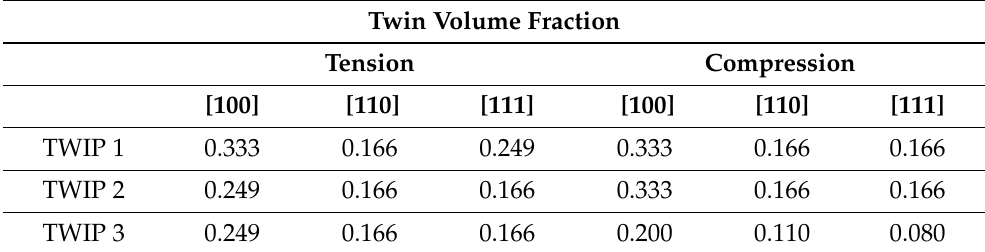
Table 6. Highest values of twin volume fraction for TWIP 1, 2, and 3 steels under tension and